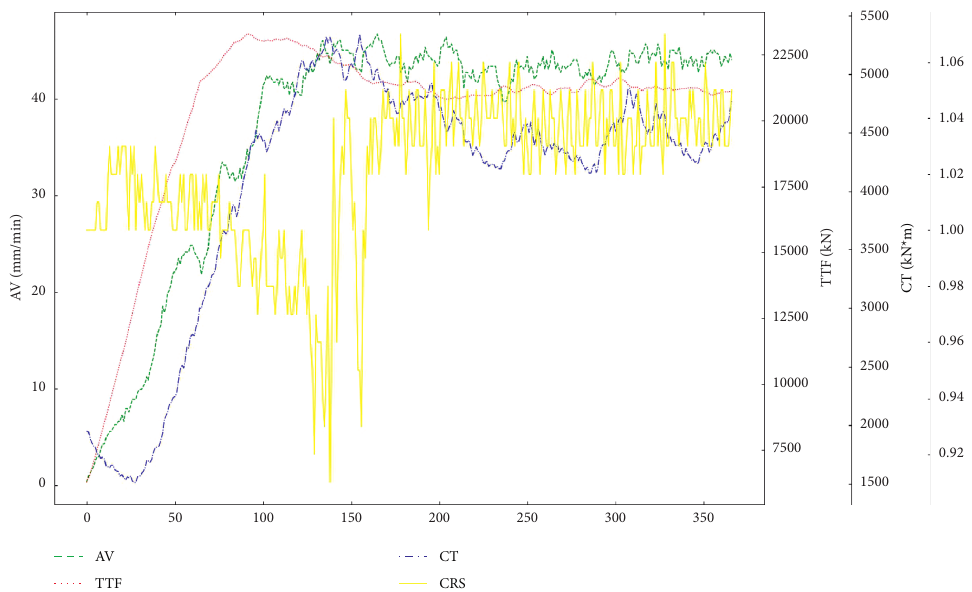
Figure 2: A section of normal tunneling data in Ring